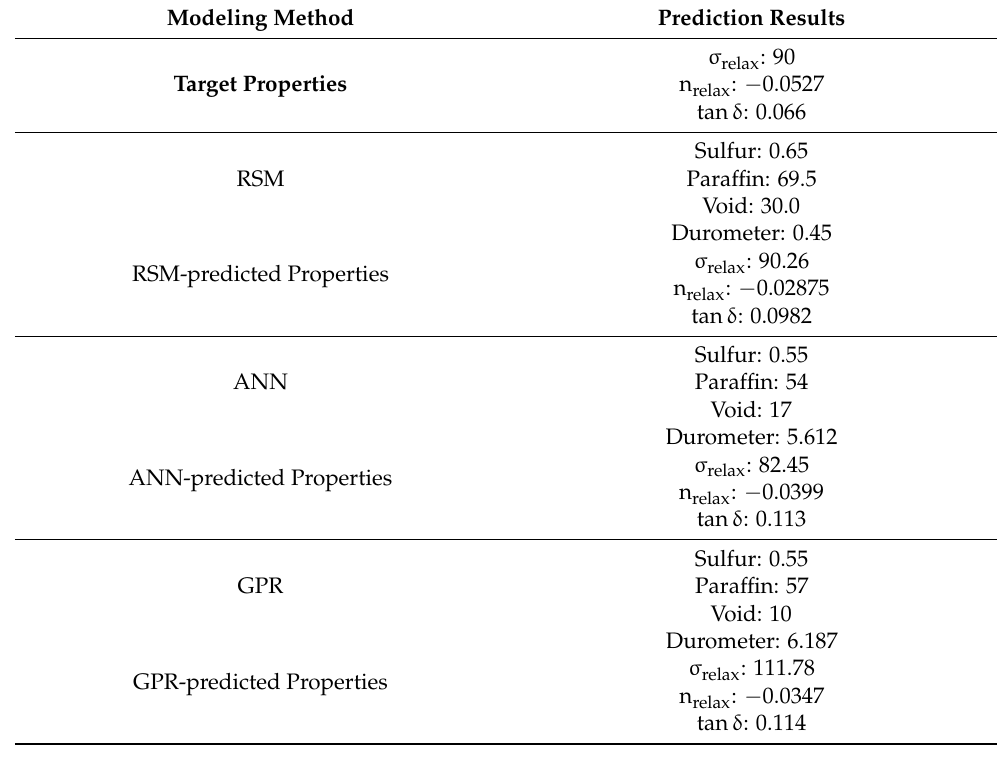
Table 6. Below summarizes the blends that were classified as the optimal blend based on target properties. Modeling Method Prediction